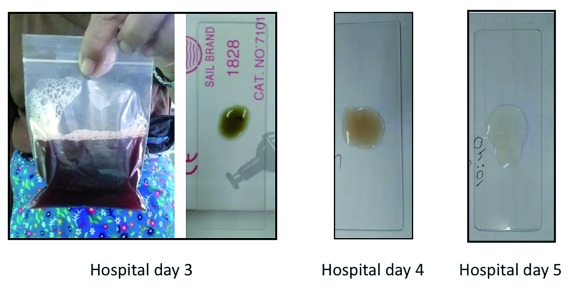
The resolution of haemoglobinuria in case 2.